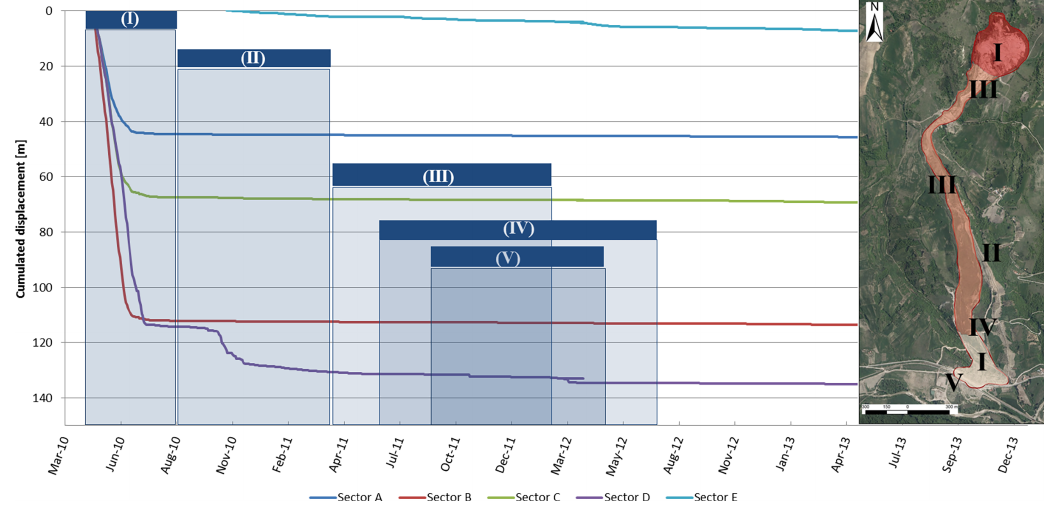
Figure 10. Displacement time series of representative points within the monitored sectors and verification of the efficiency of works with the time history of the velocity recorded at critical points: (I) drainage of the upstream and lower sector; (II) Rio Nocelle water channel- ing (Fig. 11, no. 7–10); (III) upper-medium sector works; (IV) medium-low sector works; and (V) toe sector works. See Fig. 11 for the stabilization works details and location.